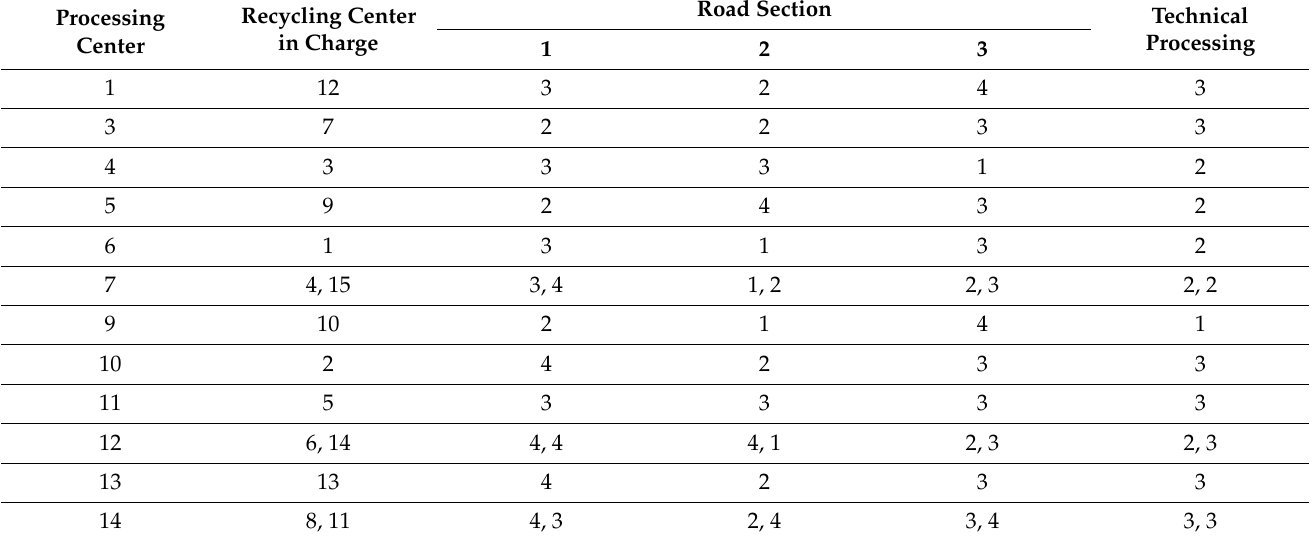
Table 12. Class III sample solution